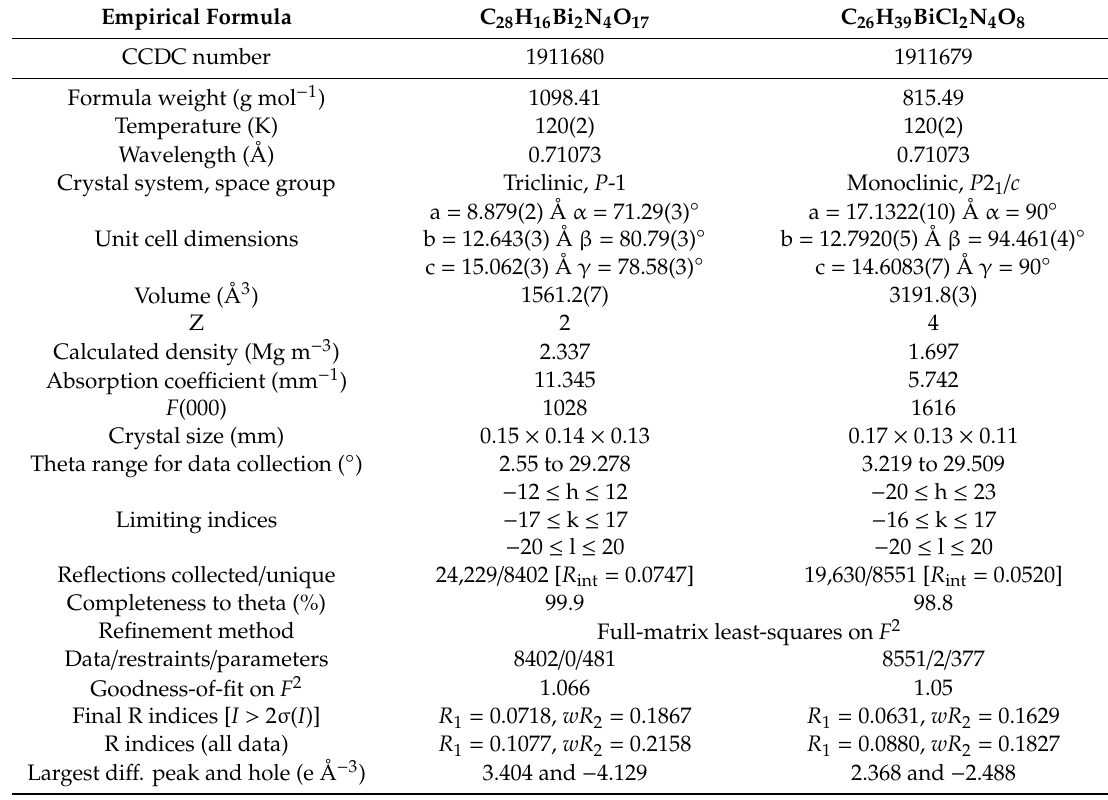
Table 6. Crystal data and structure refinement for 1 and 2